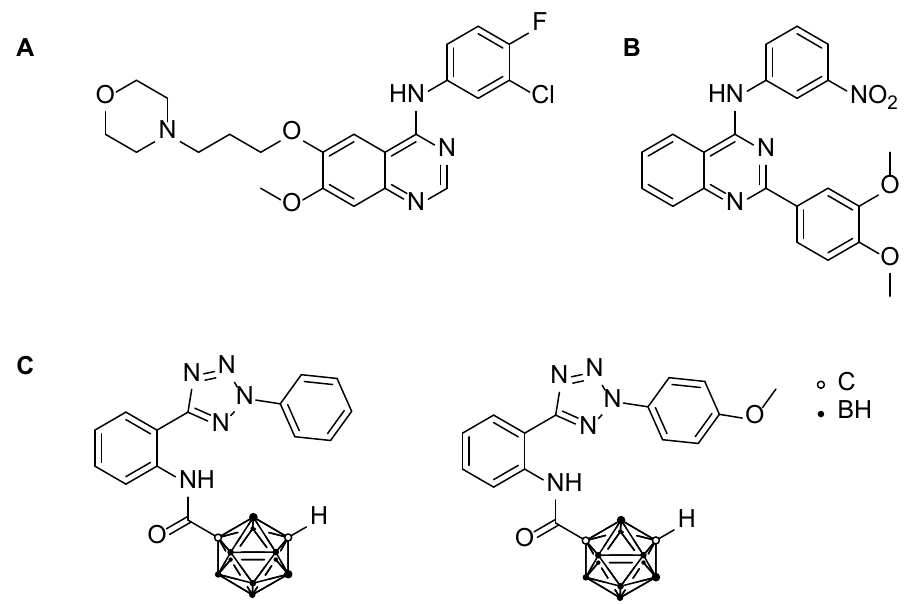
Figure 1. Molecular structures of known ABCG2 inhibitors of different classes. ( A ) Tyrosine kinase inhibitor gefitinib; ( B ) one of the strongest 2-phenyl-quinazoline-based ABCG2 inhibitors known [24]; ( C ) the first reported carborane-functionalized ABCG2 inhibitors [33].